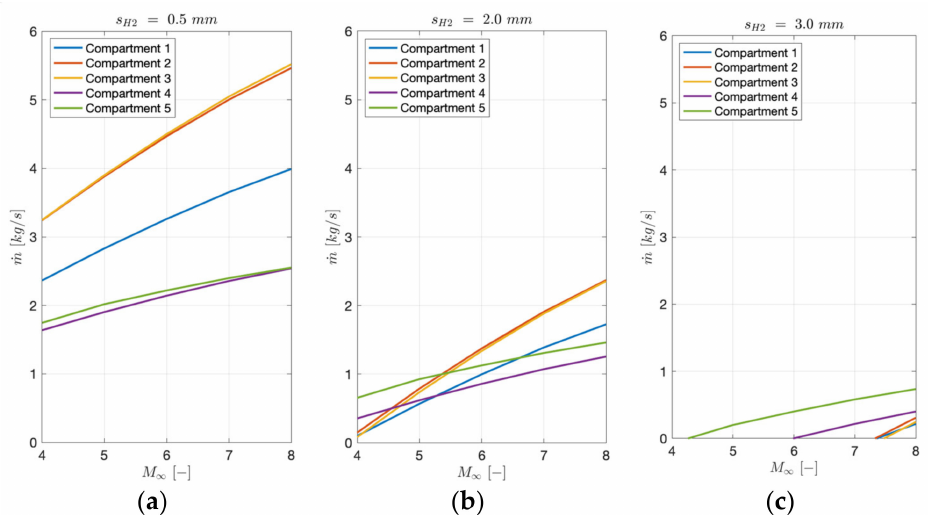
Figure 22. ( a ) Variation of the air mass flow supplied by the ECS with Mach number for each cabin compartment (thickness of the boil-off hydrogen insulation layer equal to 0.5 mm); ( b ) variation of the air mass flow supplied by the ECS with Mach number for each cabin compartment (thickness of the boil-off hydrogen insulation layer equal to 2 mm); ( c ) variation of the air mass flow supplied by the ECS with Mach number for each cabin compartment (thickness of the boil-off hydrogen insulation layer equal to 3